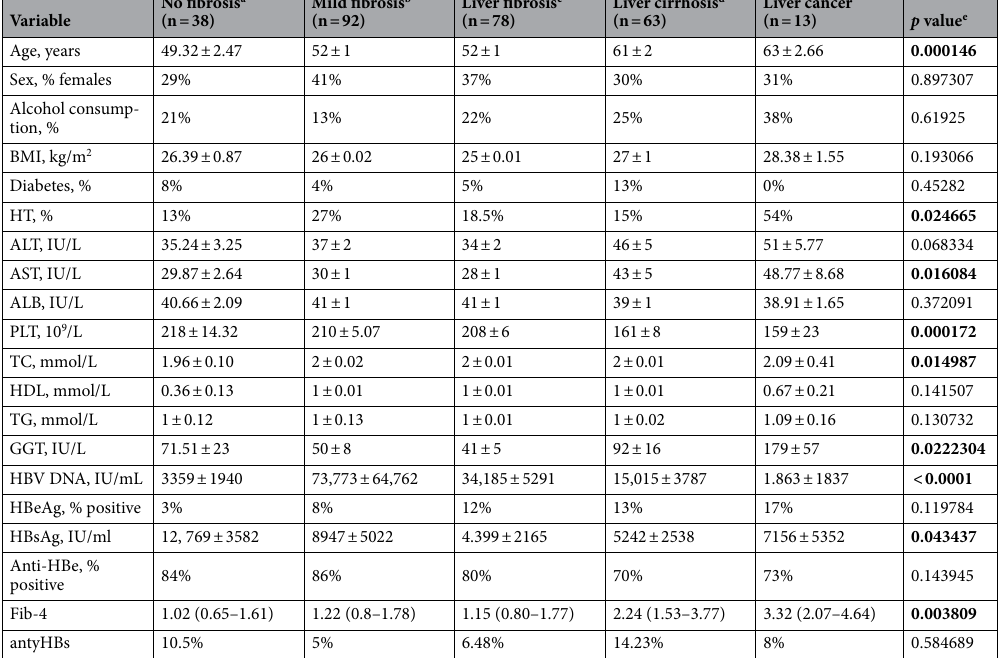
Table 1. Characteristics of chronic hepatitis B patients with liver cirrhosis, hepatic fibrosis, and healthy controls. Significant values are in bold. Unless stated otherwise, data are shown as the mean ± standard error of the mean; † median value (interquartile range); a no scarring (stage 0); b fibrosis stage I; c fibrosis stages II–III; d fibrosis stage IV; e liver cirrhosis vs. no fibrosis; p values less than 0.05 are shown in bold. BMI body mass index, HT portal hypertension, ALT alanine aminotransferase, AST aspartate aminotransferase, ALB albumin, PLT platelet count, TC total cholesterol, HDL high-density lipoprotein, TG triglycerides , GGT gamma- glutamyl